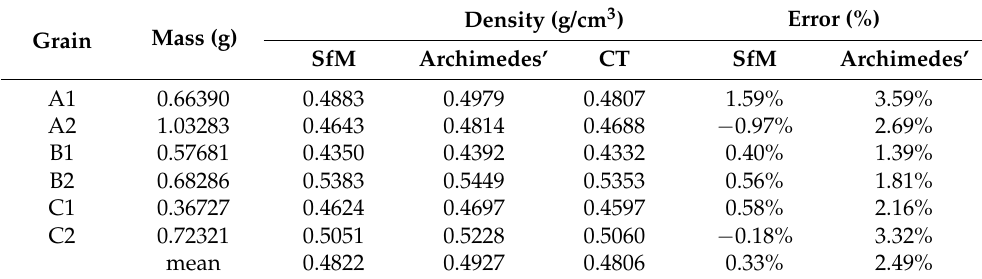
Table 3. Particle density results obtained with the photogrammetry-based (SfM), laboratory (Archimedes’ method), and computed tomography volume measurements.